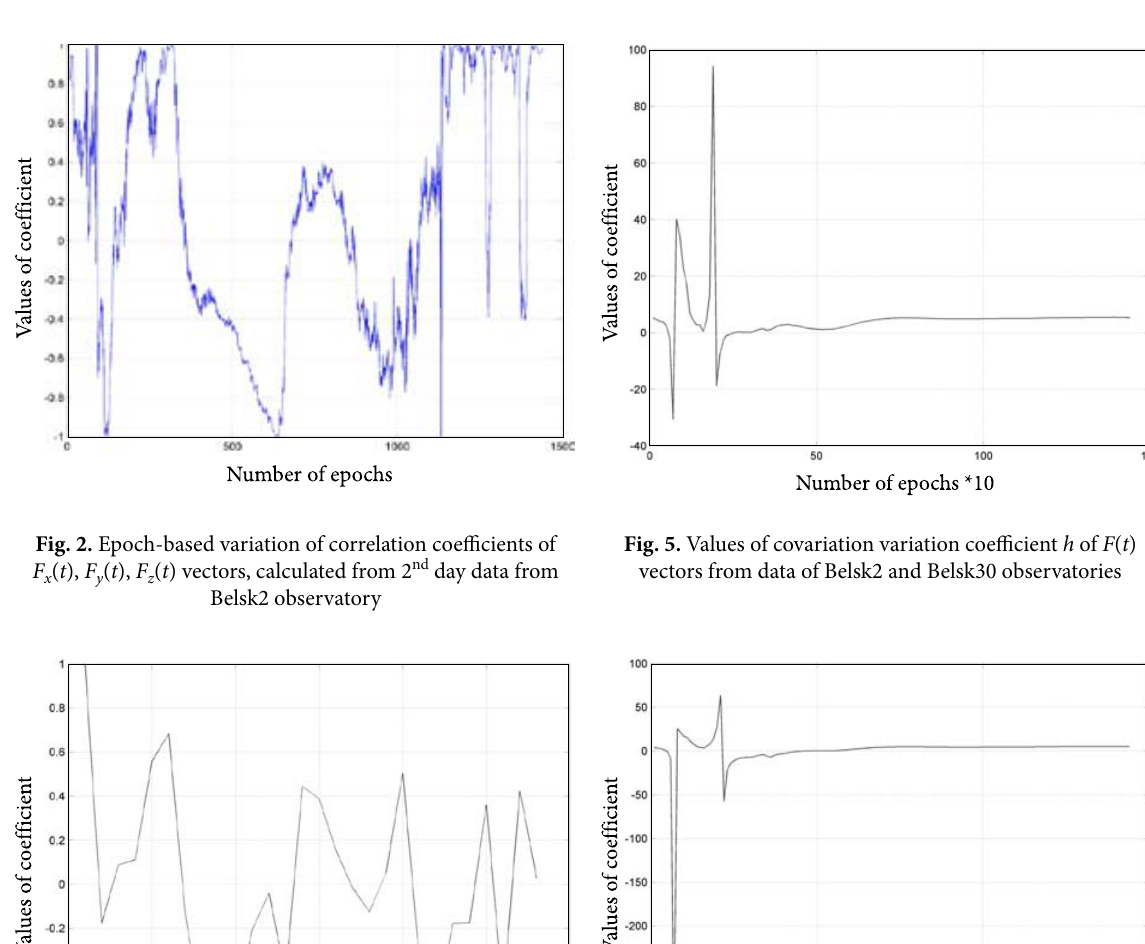
Fig. 4. Values of covariation variation coefficient h of vector F ( t ) from Hel30 observatory